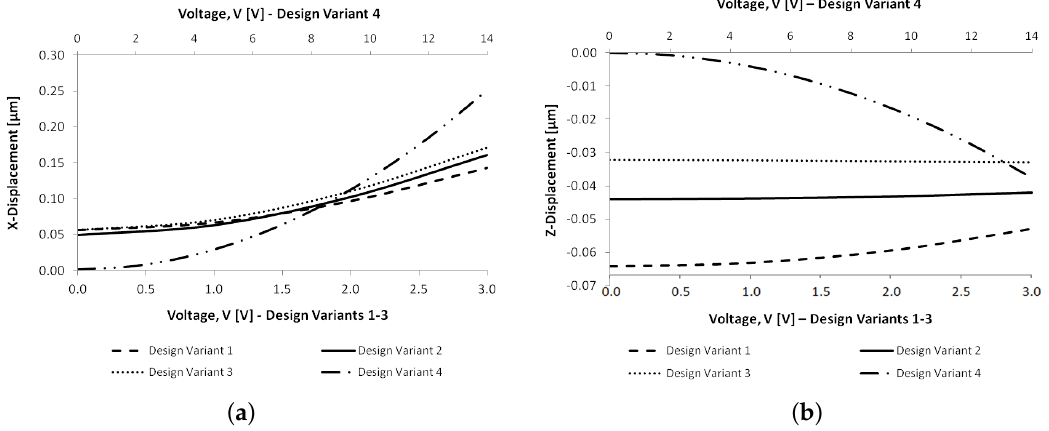
Figure 13. Simulated steady-state displacement profiles of Design Variants 1-4 with applied potential: x -displacement (forward displacement) of the microgripper arm tips ( a ); and z -displacement (out-of-plane displacement) of the microgripper arm tips ( b